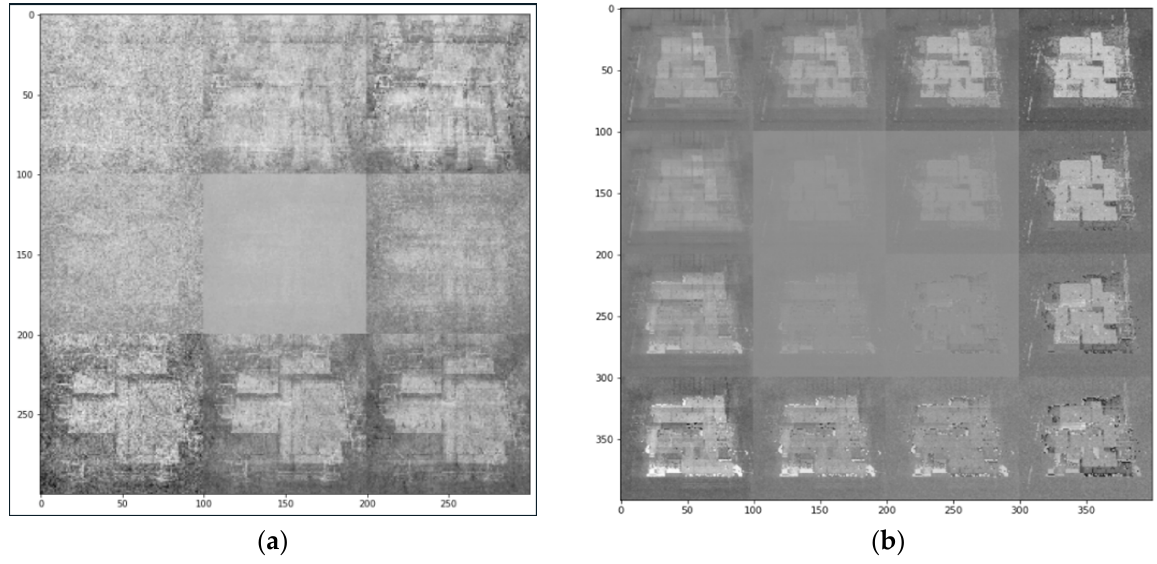
Figure 6. Resulting output game maps obtained after ( a ) the training of the VAE model, and ( b ) the mixing process (based on raw game maps of Arknights obtained from [42]).